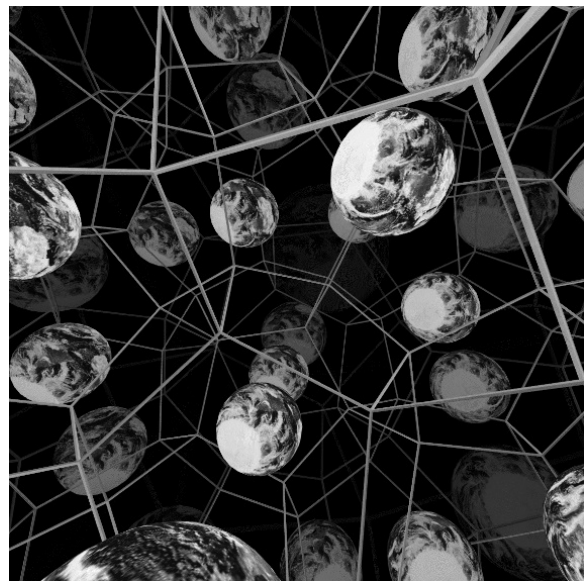
Figure 2. The Poincaré Dodecahedral Space can be described as the interior of a spherical ball whose surface is tiled by 12 curved regular pentagons. When one leaves through a pentagonal face, one returns to the ball through the opposite face after having turned by 36°. As a consequence, the space is finite but without boundaries, therefore one can travel through it indefinitely. One has the impression of living in a UC space 120 times larger, paved with dodecahedra that multiply the images like a hall of mirrors. The return of light rays that cross the walls produces optical mirages: a single object has several images. This numerical simulation calculates the closest phantom images of the Earth, which would be seen in the UC space (Image courtesy of J. Weeks). There are seventeen multi ‐ connected Euclidean spaces (for an exhaustive study, see [7]), the simplest of which being the hypertorus T 3 , whose fundamental domain is a parallelepiped of which opposite faces are identified by translations. Seven of these spaces have an infinite volume, ten are of finite volume, six of them being orientable hypertori. All of them could correctly describe the spatial part of the flat universe models, as they are consistent with recent observational data which constrain the space curvature to be very close to zero. Note that in current inflationary scenarios for the big bang, one can always have a nearly flat universe at present without fine ‐ tuning the initial value of